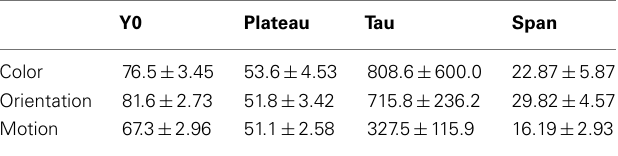
Table 1 | Exponential fit parameters for mean data, expressed as the best fit value and its 95% confidence interval (95%